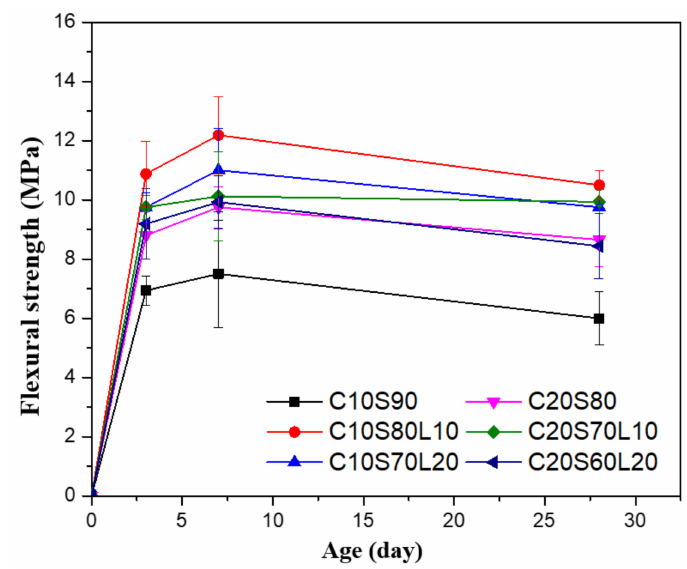
Figure 8. Flexural strength of alkali-activated slag mortar with di ff erent